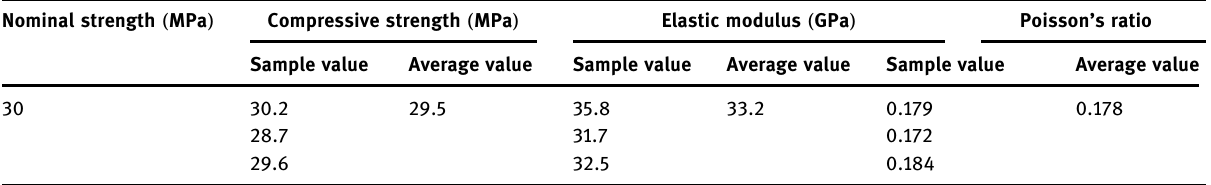
Table 2: Material properties of concrete Nominal strength ( MPa )